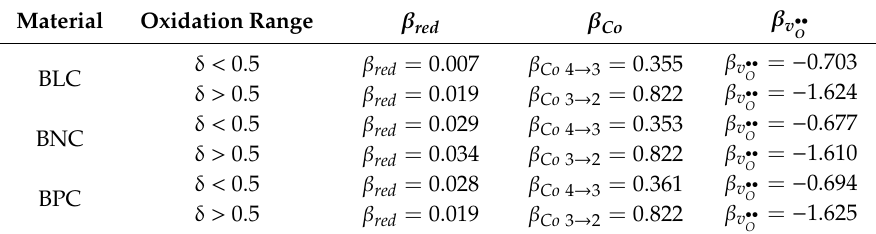
Table 2. Chemical expansion coe ffi cients for BLC, BPC, and